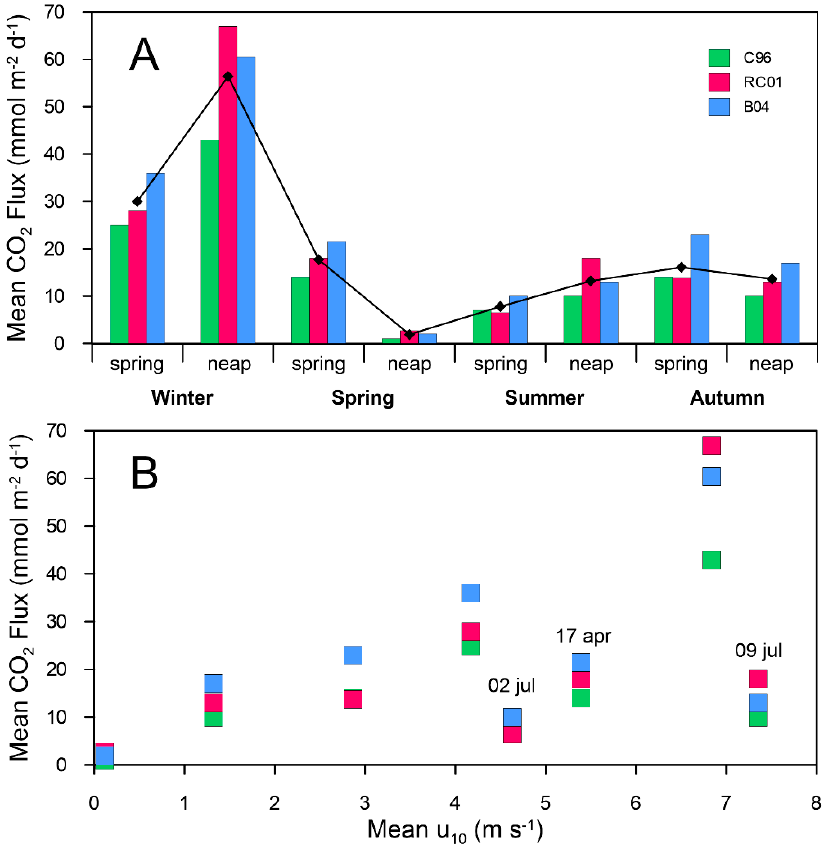
Figure 7. Average CO 2 fluxes for ( A ) all seasons sampled during 2007, and ( B ) as a function of wind speed (u 10 ). Positive values denote a flux from the water to the atmosphere. The values were calculated with three parameterizations: Carini et al. (1996) algorithm (C96), Raymond and Cole (2001) algorithm (RC01), and Borges et al. (2004a) algorithm (B04). Diamonds on panel A show average air–water fluxes for each parameterization.